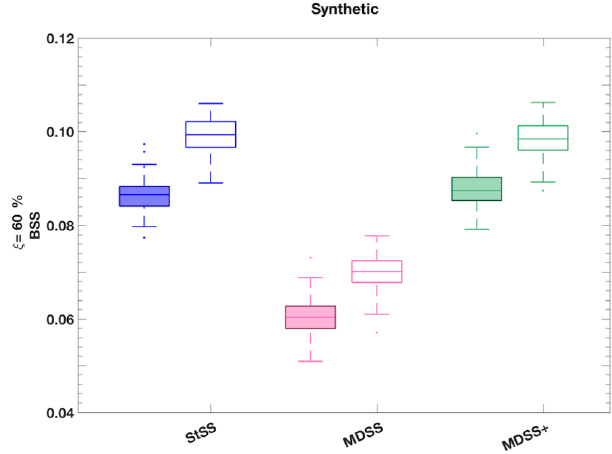
Figure 12. Box plots of BSS of power ramp events identified in 6h time windows from synthetic forecast scenarios generated with the StSS (blue), MDSS (pink), and MDSS + (green) methods. BSSs are shown for up-ramps (filled box plots) and down-ramps (non-filled box plots). Ramp events with a power threshold of ξ = 60% change in the turbine power capacity are shown. The box plots display the interquartile range (rectangle region), the median (middle line within rectangle), outliers (dots), and values outside the interquar- tile range but not considered outliers (lower and upper whisker) of the distributions. Outliers are values more than 1.5 times the in- terquartile